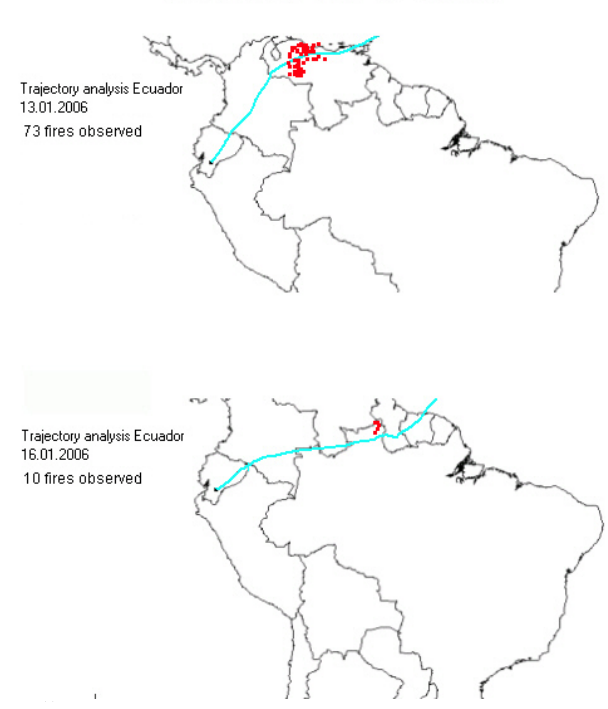
Fig. 11. Same as Fig. 8, but for sample #62.